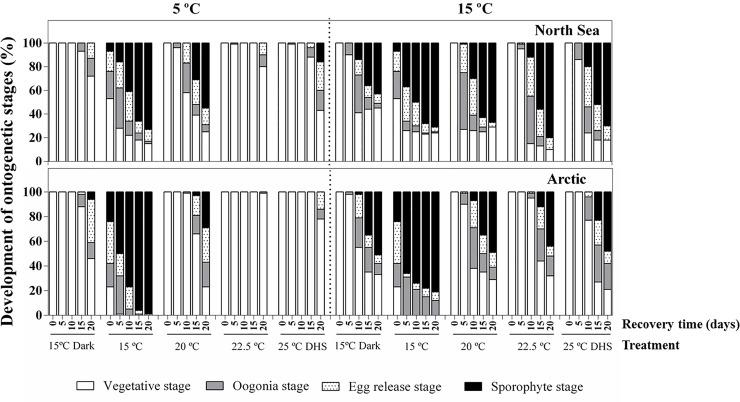
Development of gametogenesis stages over recovery.Development of ontogenetic stages in the North Sea and Arctic populations of Laminaria digitata over recovery time at 5°C and 15°C from different treatments (15°C dark, 15°C, 20°C, 22.5°C and 25°C DHS) (mean values, n = 4). Counting was performed every 5 days over a period of 20 days. SE-values are omitted for clarity. Note that day 0 of the recovery phase is day 8 of the temperature exposure phase.